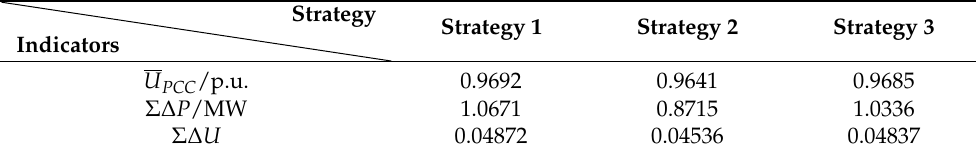
Figure 12. ( a ) The adaptive gain coefficient of each WT under the three different strategies; ( b ) The reactive power output of each WT under the three different strategies; ( c ) The PCC voltage under the three different strategies. The comparison diagram of the three different strategies in Scenario 1. Table 4. The contrast indicators’ calculation results of the three different strategies in Scenario 1. Indicators